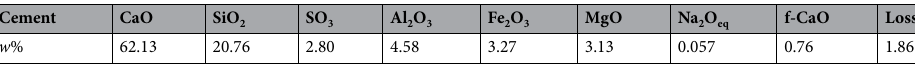
Table 1. Chemical components of the cement (w%, by mass).